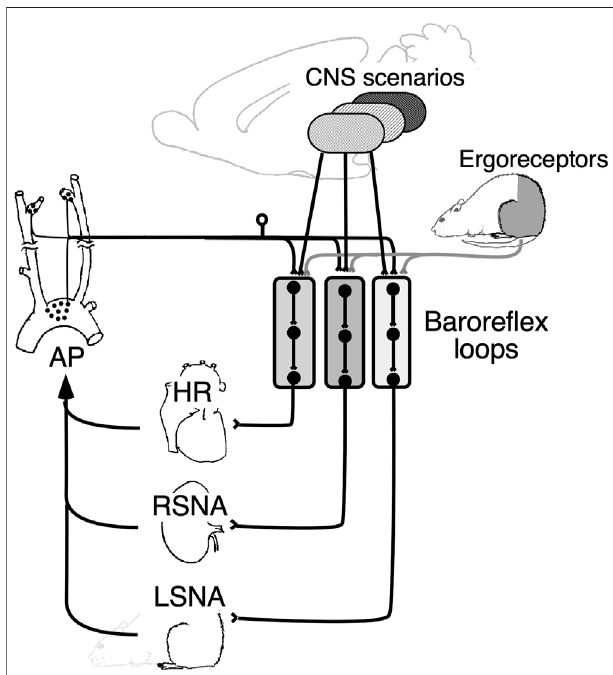
FIGURE 5 | Schematic diagram showing the role of parallel barore fl ex loops in regulating sympathetic nerve activity and, thereby, arterial pressure (AP).Parallelbarore fl exloopsregulateheartrate(HR),renalsympatheticnerve activity (RSNA),andlumbarsympatheticnerveactivity (LSNA)separately to generate region-speci fi c changes in the SNA. Each arterial barore fl ex loop receives similar stimulus information from the muscle ergoreceptors, but it receivesseparate andintegratedinformationfromtheCNS abovethemedulla to optimize AP as a whole body.